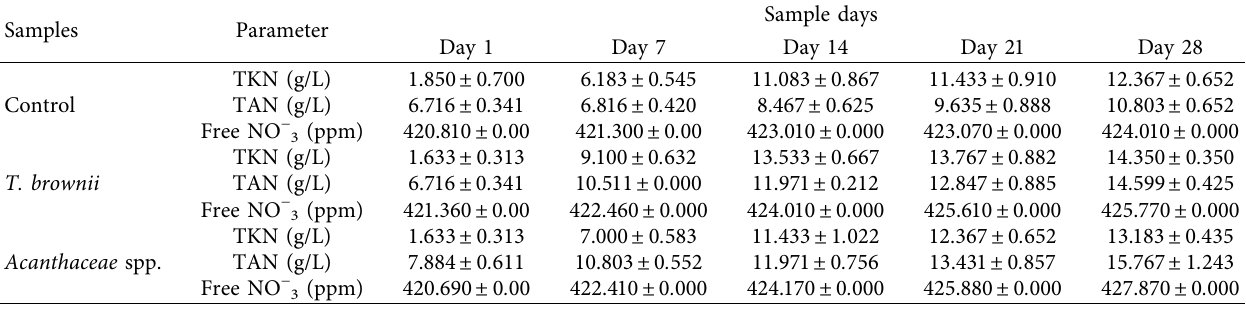
Table 6: Variation of total Kjeldahl nitrogen (TKN), total ammoniacal nitrogen (TAN), and nitrogen as free nitrates in bioslurry over the retention period.